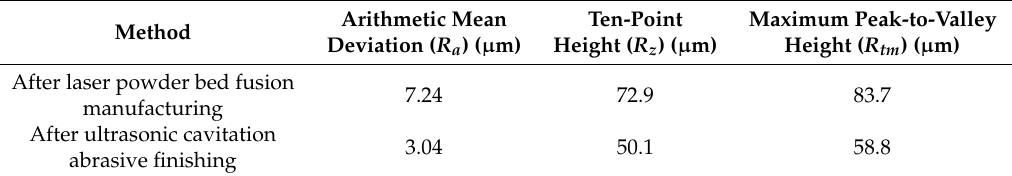
Table 5. The roughness parameters ( R a , R z , R tm ) of the 20kH13 (AISI 420) steel sample surfaces before and after cavitation-abrasive finishing (after Gaussian